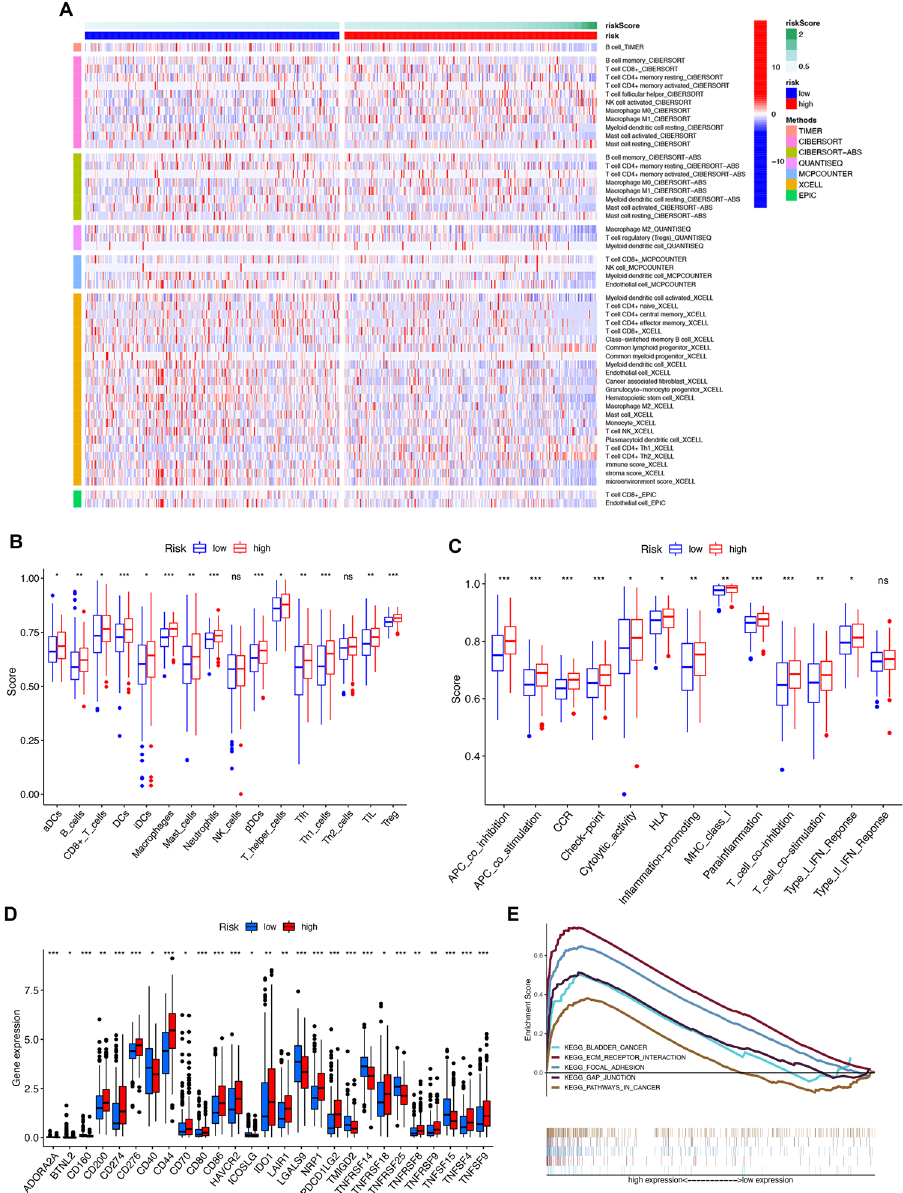
Figure 7. Immune infiltration, immune function, immune checkpoint and gene set enrichment analysis (GSEA) analysis. ( A ) Heatmap for immune cell infiltration landscape based on the TIMER, CIBERSORT, CIBERSORT–ABS, QUANTISEQ, MCPCOUNTER, XCELL and TIMER algorithms among high and low risk group. The heatmap was created by using “pheatmap” package in R 4.2.1 (https:// www.r- proje ct. org/). ( B ) Abundance of 16 infiltrating immune cell types between high- and low-risk groups. ( C ) Abundance of 13 immune-related function score difference in high- and low-risk group ( D ) Expression of immune checkpoints in high- and low-risk groups. ( E ) According to GSEA enrichment analysis, m7G-related lncRNAs were may be involved in ecm receptor interaction, focal adhesion, gap junction, bladder cancer and pathways in cancer. Kyoto Encyclopedia of Genes and Genomes (KEGG) pathway enrichment analysis (Sourced from www. kegg. jp/ kegg/ kegg1. html). * P < 0.05; ** P < 0.01; *** P <